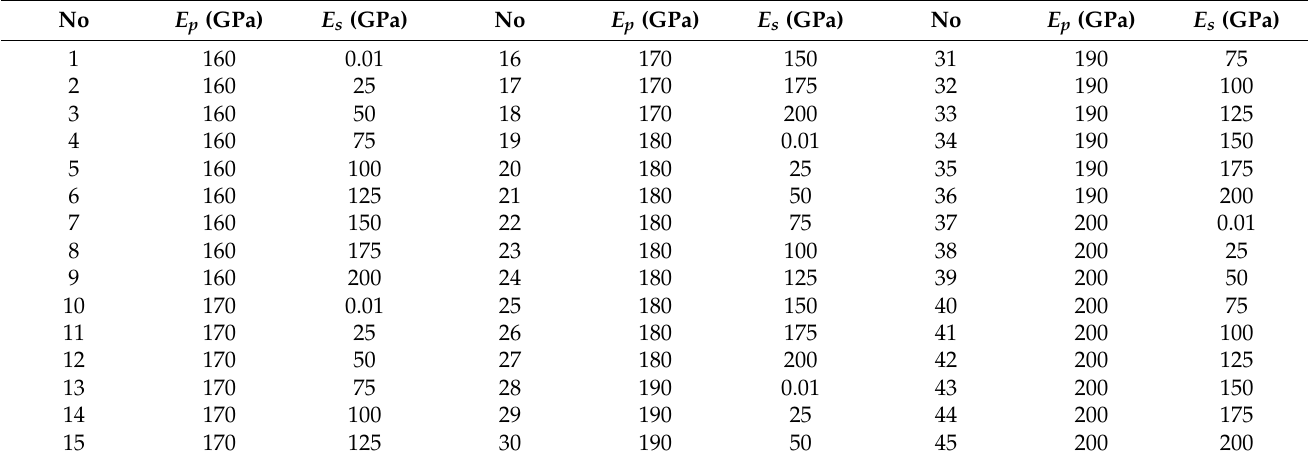
Table 2. Variable parameters in the second category of analysis—material